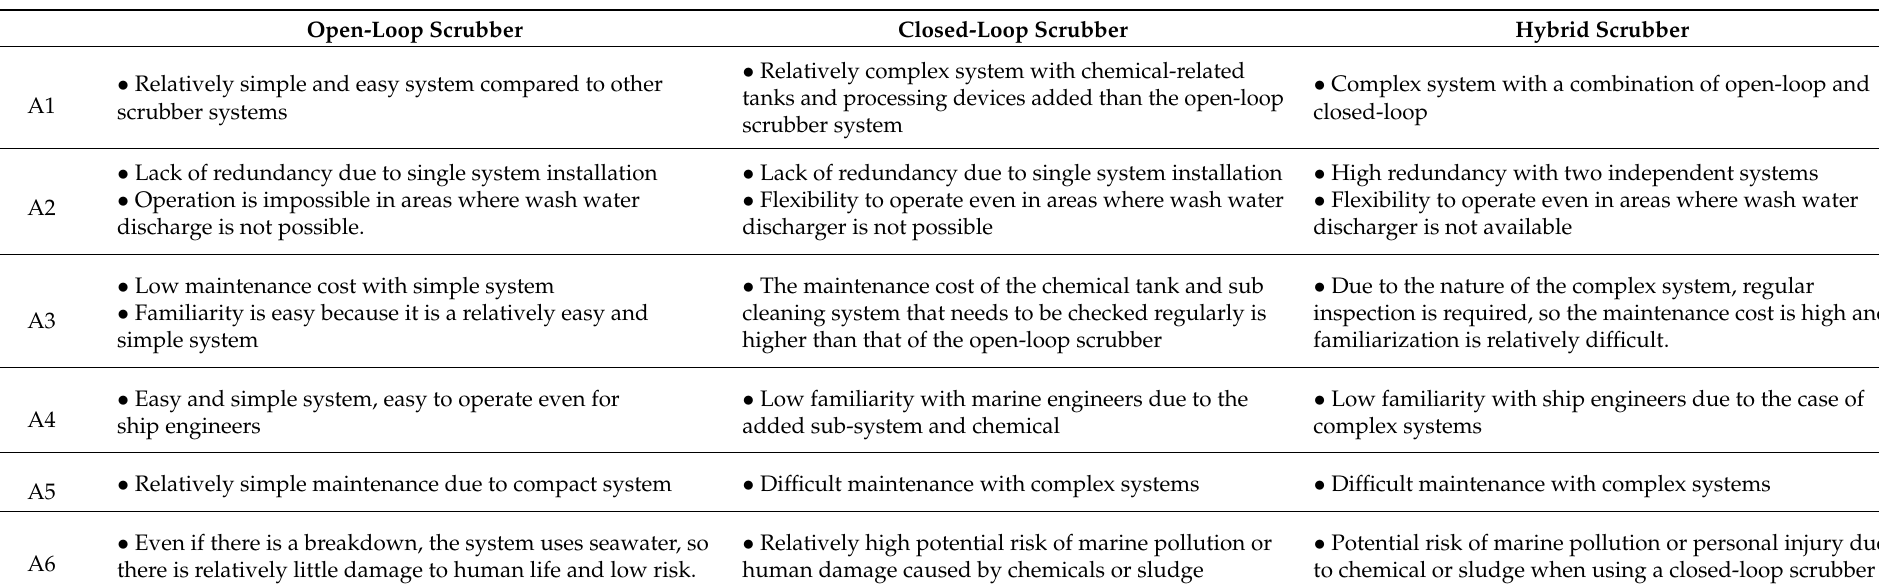
Table 9. Summary of technical